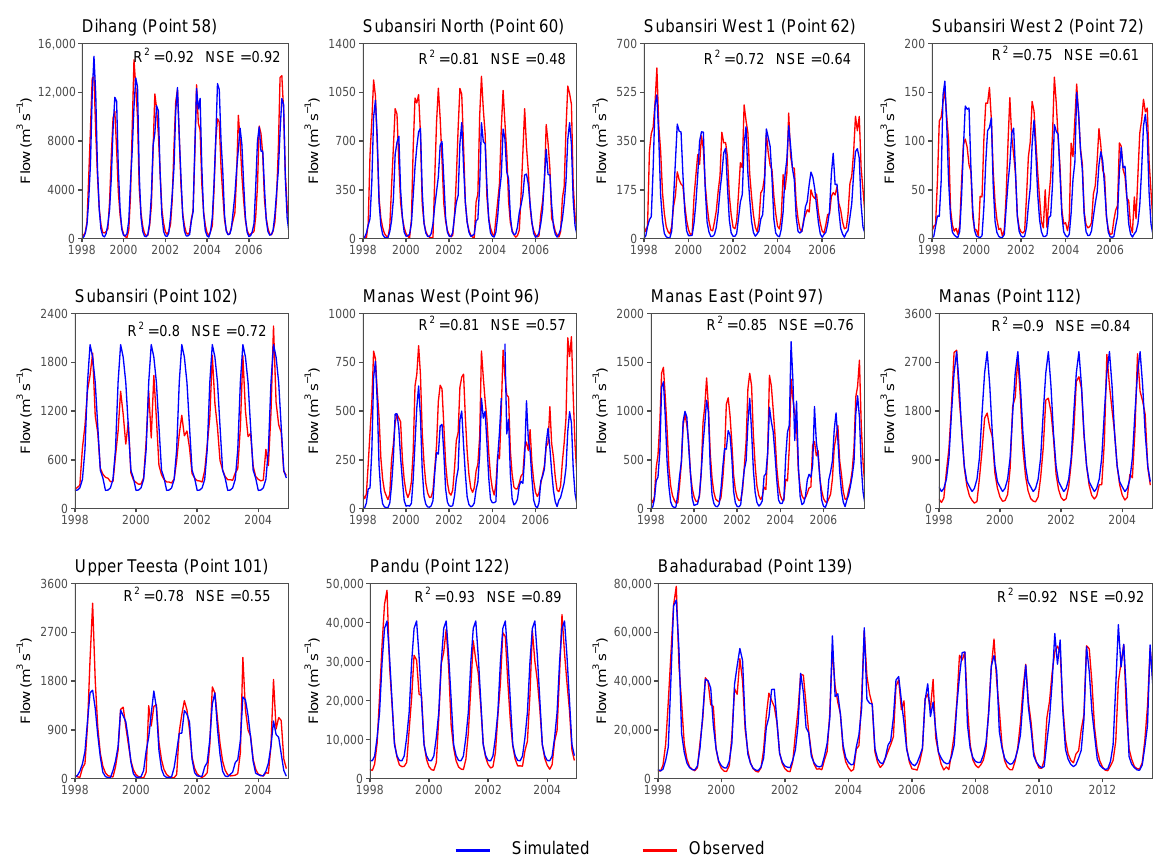
Figure 6. Brahmaputra SWAT model performance at the river points is shown in Figure 2. The blue line represents the observed streamflow, and the red represents the model